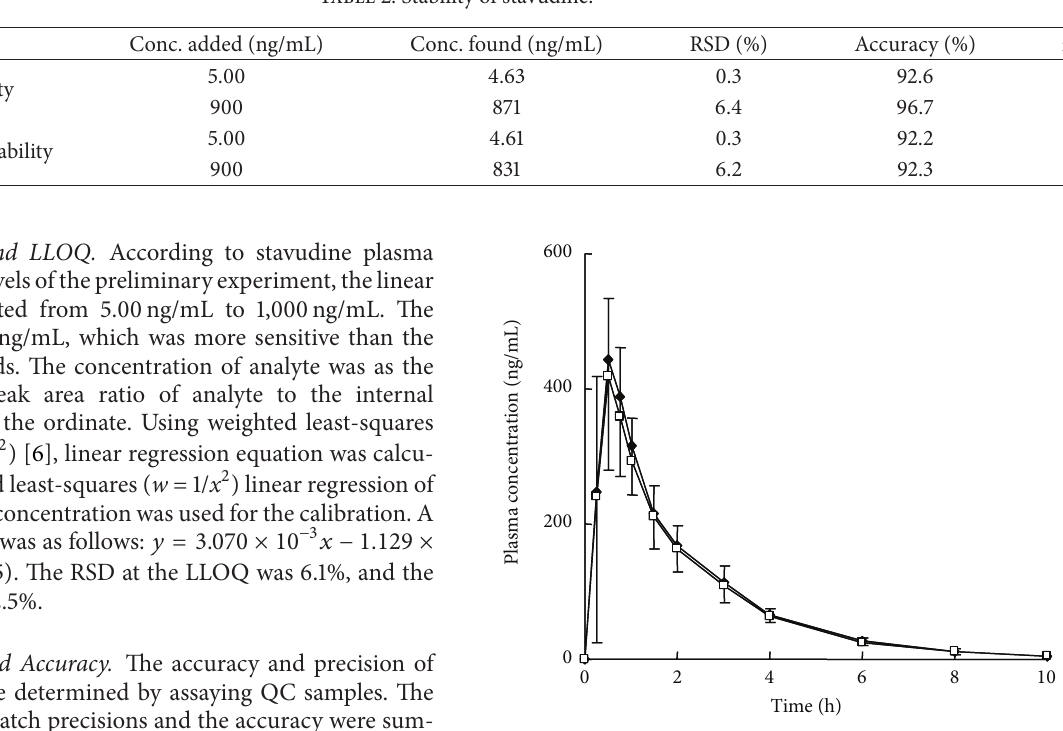
Table 2: Stability of stavudine.